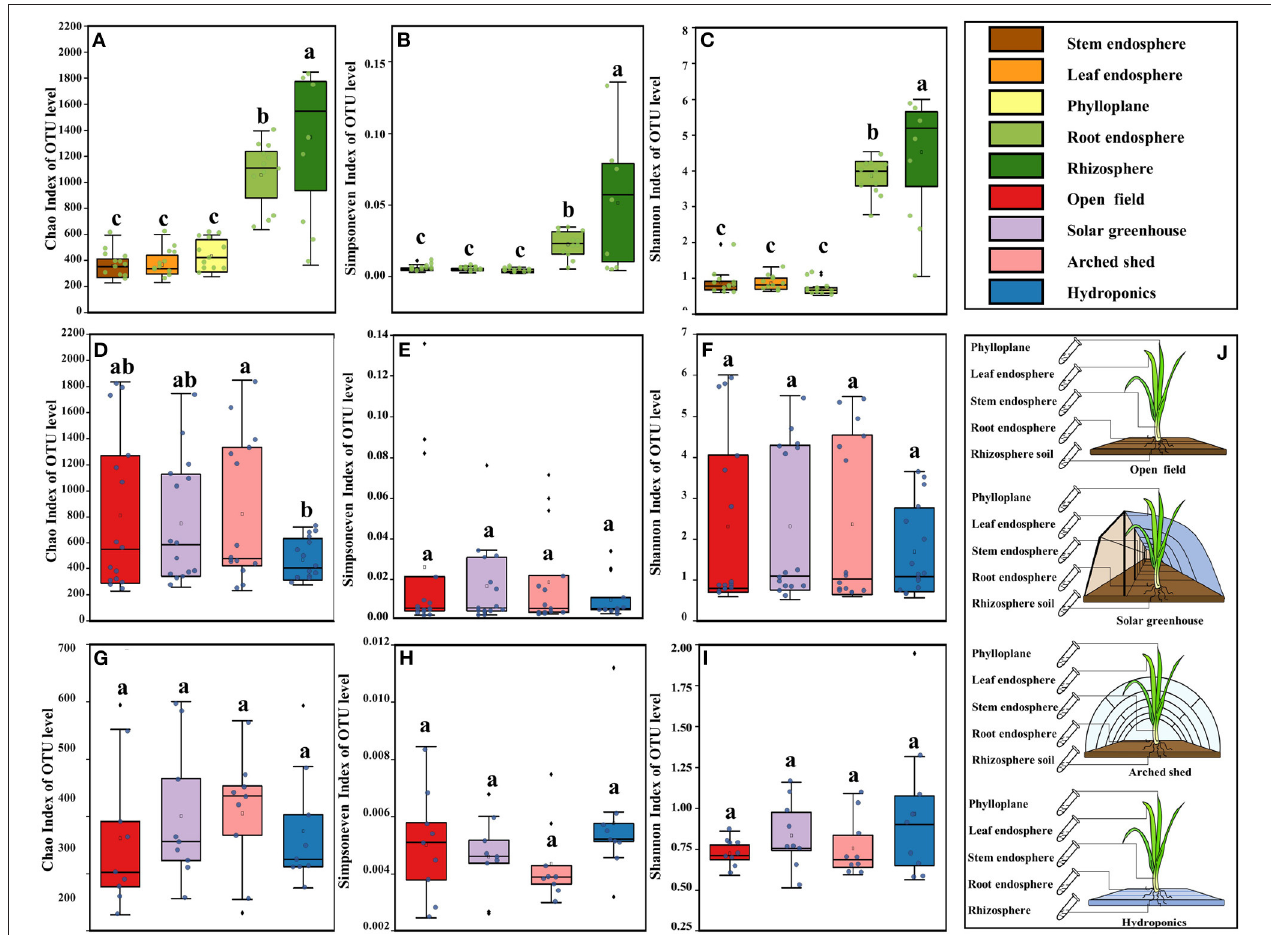
FIGURE 1 | Bacterial diversity in the different ecological compartments and growth conditions. The bacterial alpha diversity in the different ecological compartments: (A) Chao index, (B) Simpson evenness index, (C) Shannon index. Bacterial alpha diversity in the different growth conditions: (D) Chao index, (E) Simpson evenness index, (F) Shannon index. Bacterial alpha diversity in aboveground ecological compartment in different growth conditions: (G) Chao index, (H) Simpson evenness index, (I) Shannon index, (J) . Diagram of sampling in the different ecological compartments and growth conditions. The horizontal bars within boxes represent medians. The tops and bottoms of boxes represent the 75th and 25th percentiles, respectively. The upper and lower whiskers extend to 1.5 × the interquartile range from the upper edge and lower edge of the box, respectively. Different letters indicate differences between groups ( P < 0.05, ANOVA, Tukey-HSD test). The numbers of replicated samples in this figure are as follows: in different ecological compartments, n = 12, in different growth conditions, n = 15, root and rhizosphere in different growth conditions, n =